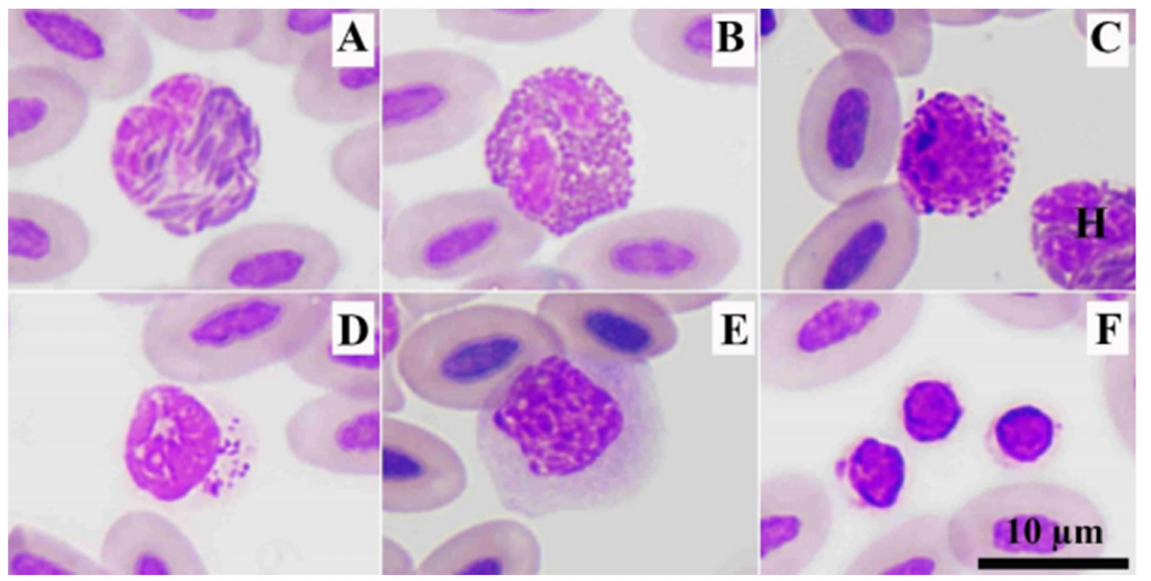
Figure 2. Blood cells of rufous-winged buzzard. Heterophil ( A ), eosinophil ( B ), basophil and het- erophil (H) ( C ), lymphocyte with azurophilic granules ( D ), monocyte ( E ), and three thrombocytes ( F ). Wright’s